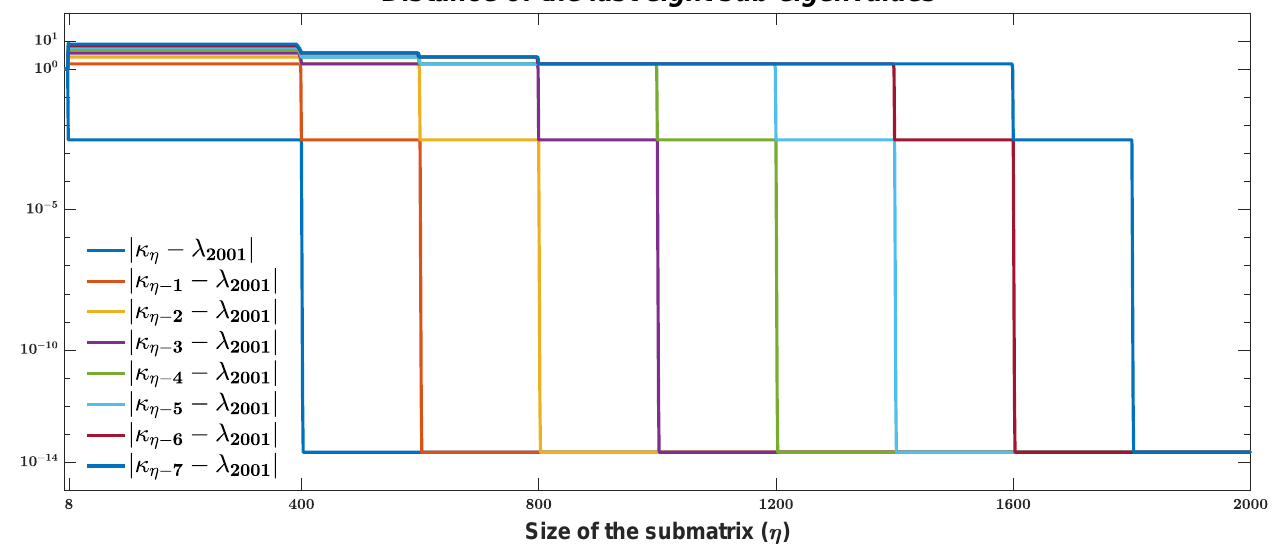
Figure 3. The distances of the last eight sub-eigenvalues.